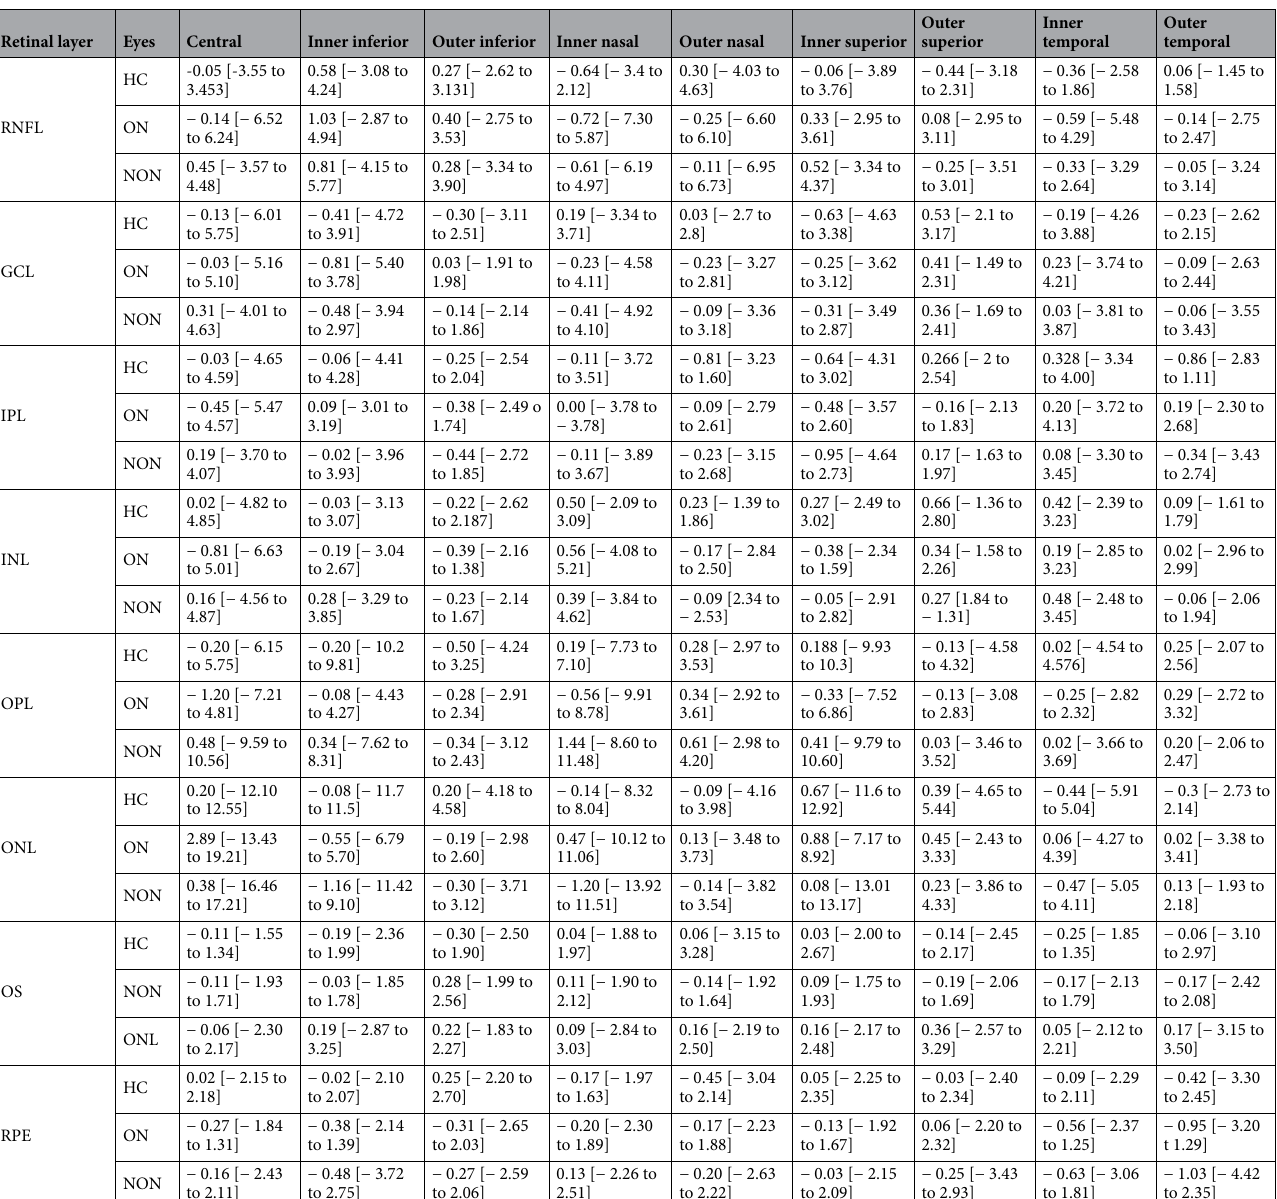
Table 2. Bland–Altmann analysis results. Mean difference and limits of agreement for the horizontal and vertical scans. All values are expressed in microns. HC healthy controls, ON eyes with optic neuritis, NON retinal pigment